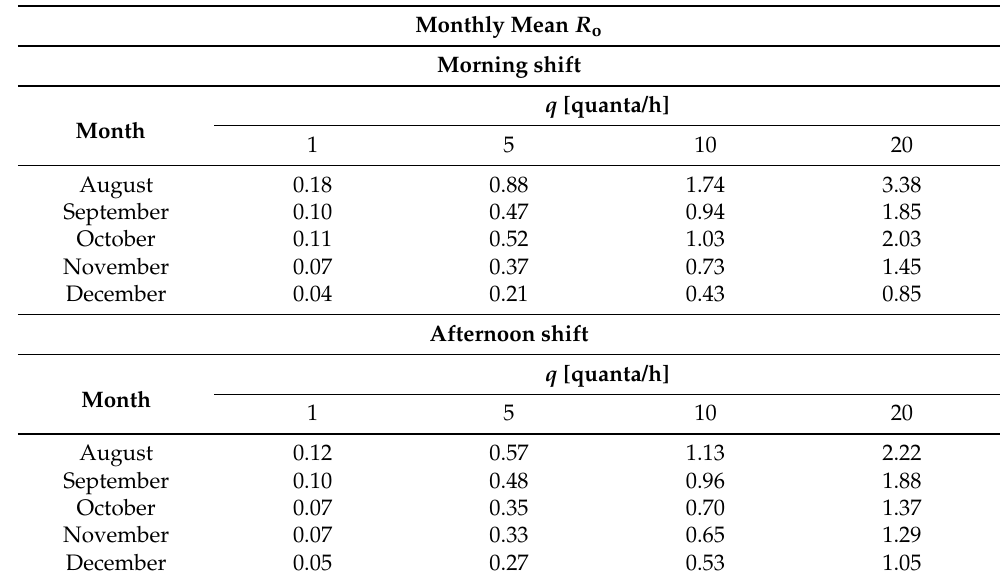
Table 5. Mean monthly estimation of the basic reproduction number for different quanta emis- sion rates.